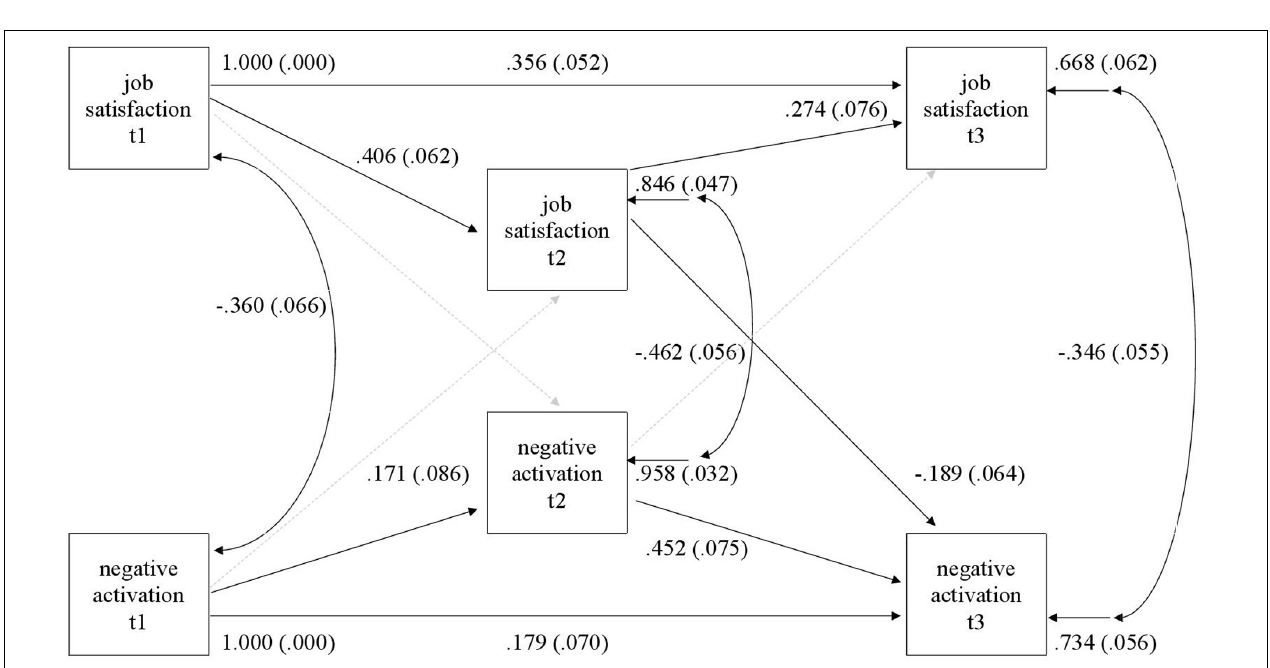
FIGURE 4 | Structural equation model (SEM) of job satisfaction and positive activation. A dashed line indicates that the path is not statistically significant.